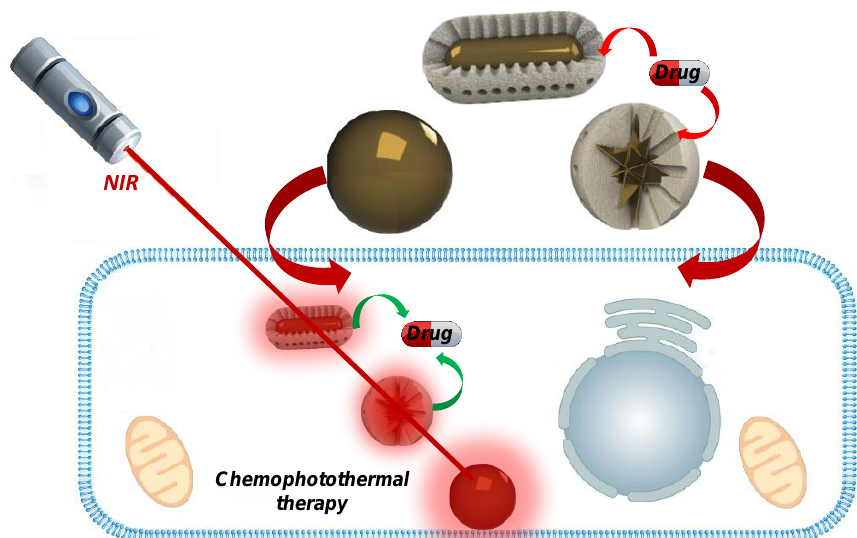
Figure 6. Au-Silica-based composites for photothermal applications. Gold nanorods, nanostars and nanoshells are able to transform near-infrared irradiation into thermal energy. The combination of such remote stimuli with drug delivery opens new possibilities for highly efficient therapeutic nanodevices. Unfortunately, the poor biodegradability of Au species makes their application poorly recommended for many